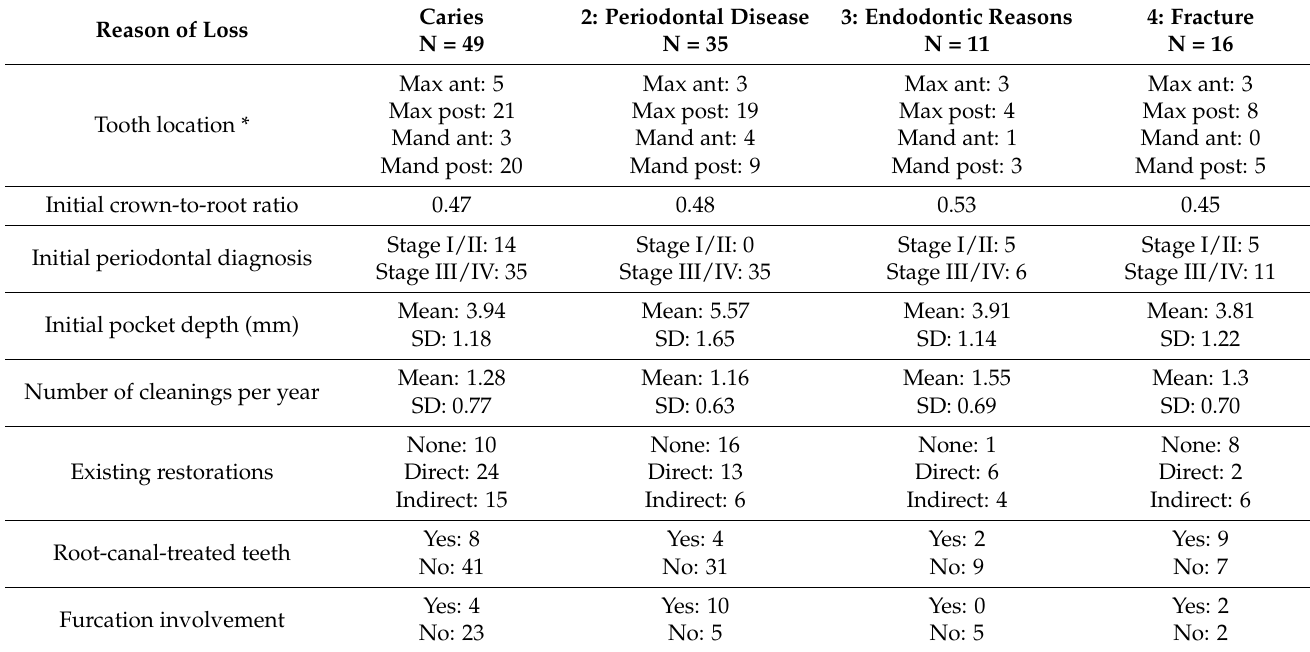
Table 2. Features of the extracted teeth for each